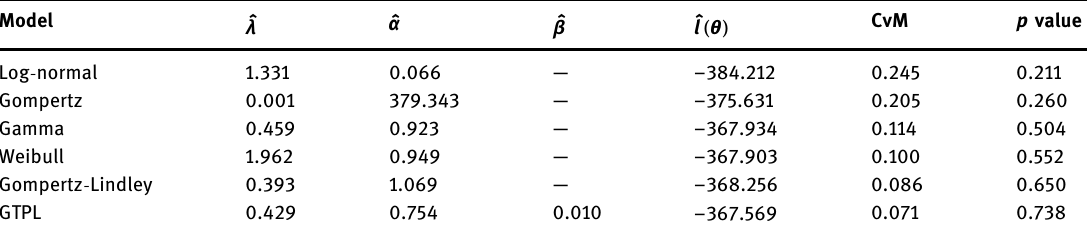
Table 3: Fitted distributions and CvM goodness - of - fi t tests for the survival data